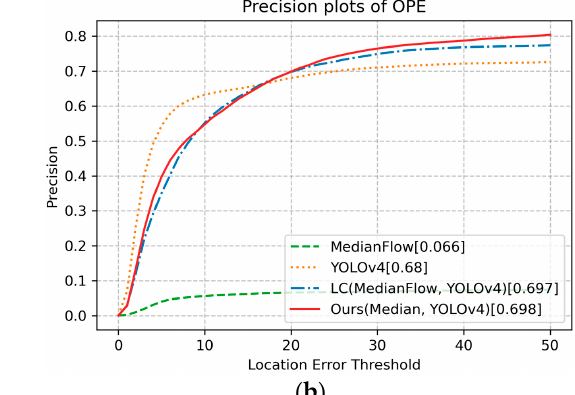
Figure 10. Success plots on di ff erent scenarios in UAVL dataset.